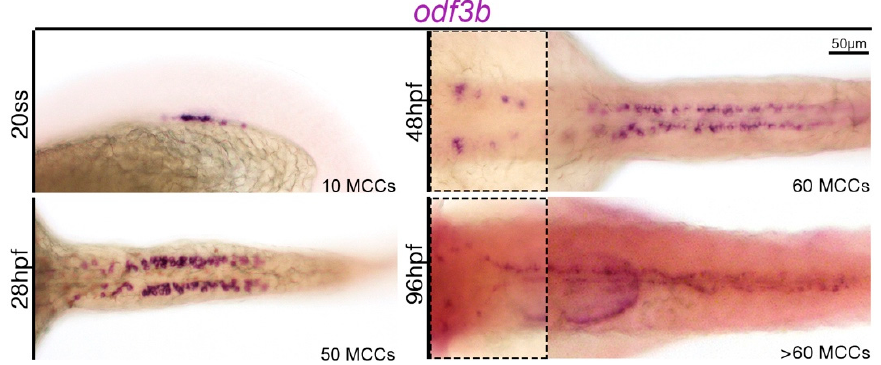
Figure 4. MCCs continue to develop throughout zebrafish organogenesis. Whole-mount in situ hybridization detects differentiating MCCs (marked by odf3b ) at various stages. Approximately 10 MCCs arise at the 20 somite stage (ss) ( top ) and more than 60 can be detected by 96 h post fertilization (hpf) ( bottom ). Inset of 48 hpf and 96 hpf panels are from more rostral regions of the embryo. By the 96 hpf stage, the hook-like-shaped arrangement of renal MCCs is visible, suggesting that these MCCs occupy the proximal convoluted tubule.